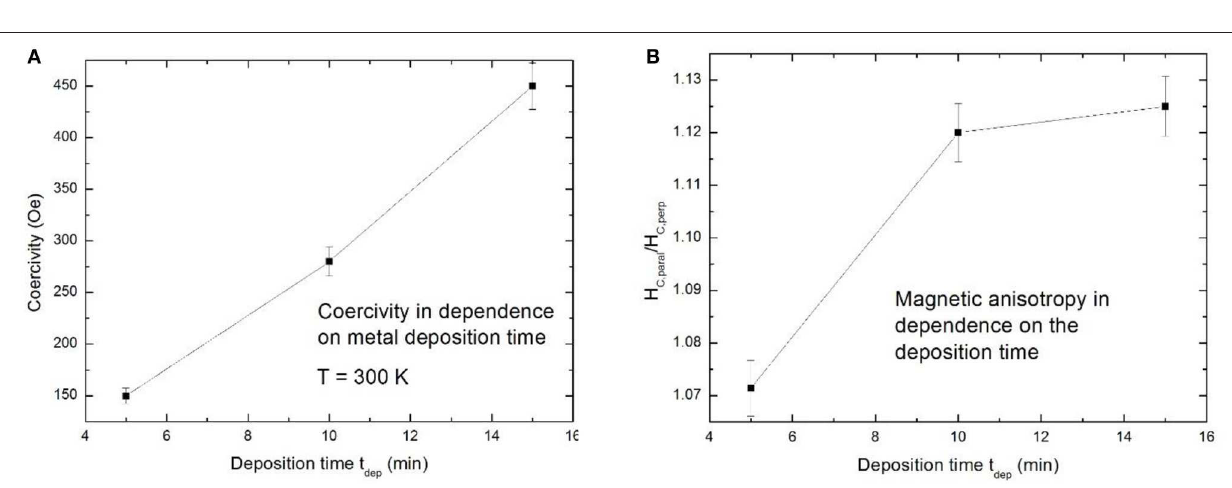
FIGURE 8 | (A) Coercivity of microPSi/Ni in dependence on the deposition time. (B) Magnetic anisotropy (H c,paral /H c,perp ) vs. filling time. Granitzer et al. [47], with